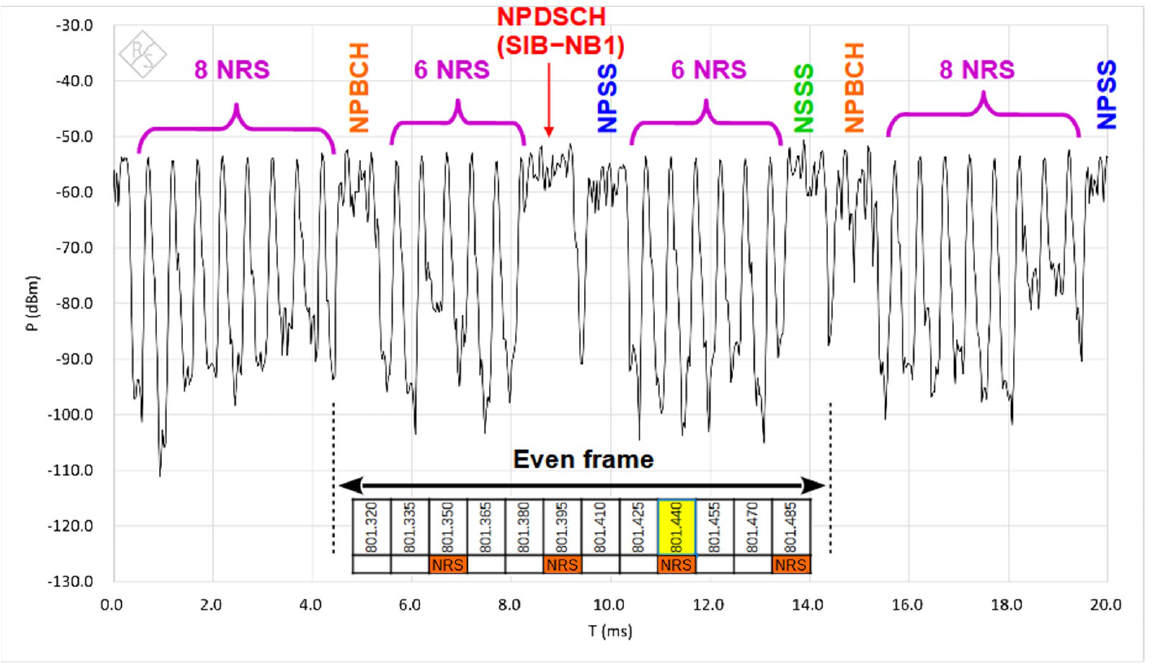
Figure 8. Example of time acquisition of a subcarrier transmitting the NRS (801.440 MHz).